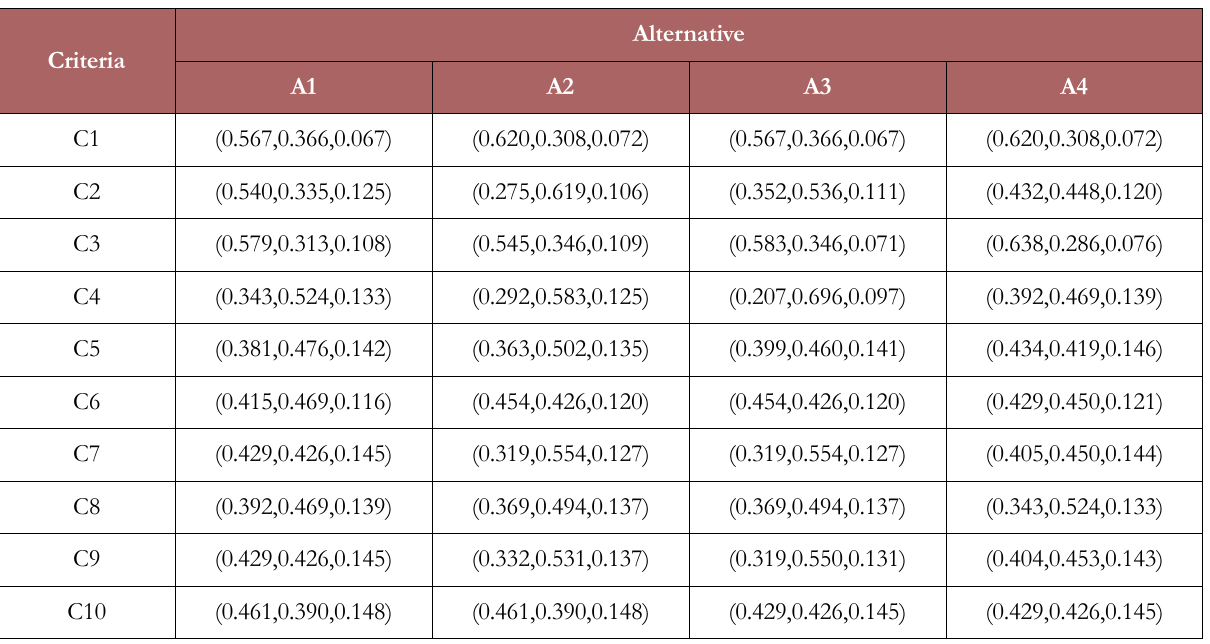
Table 18. Aggregated weighted intuitionistic fuzzy